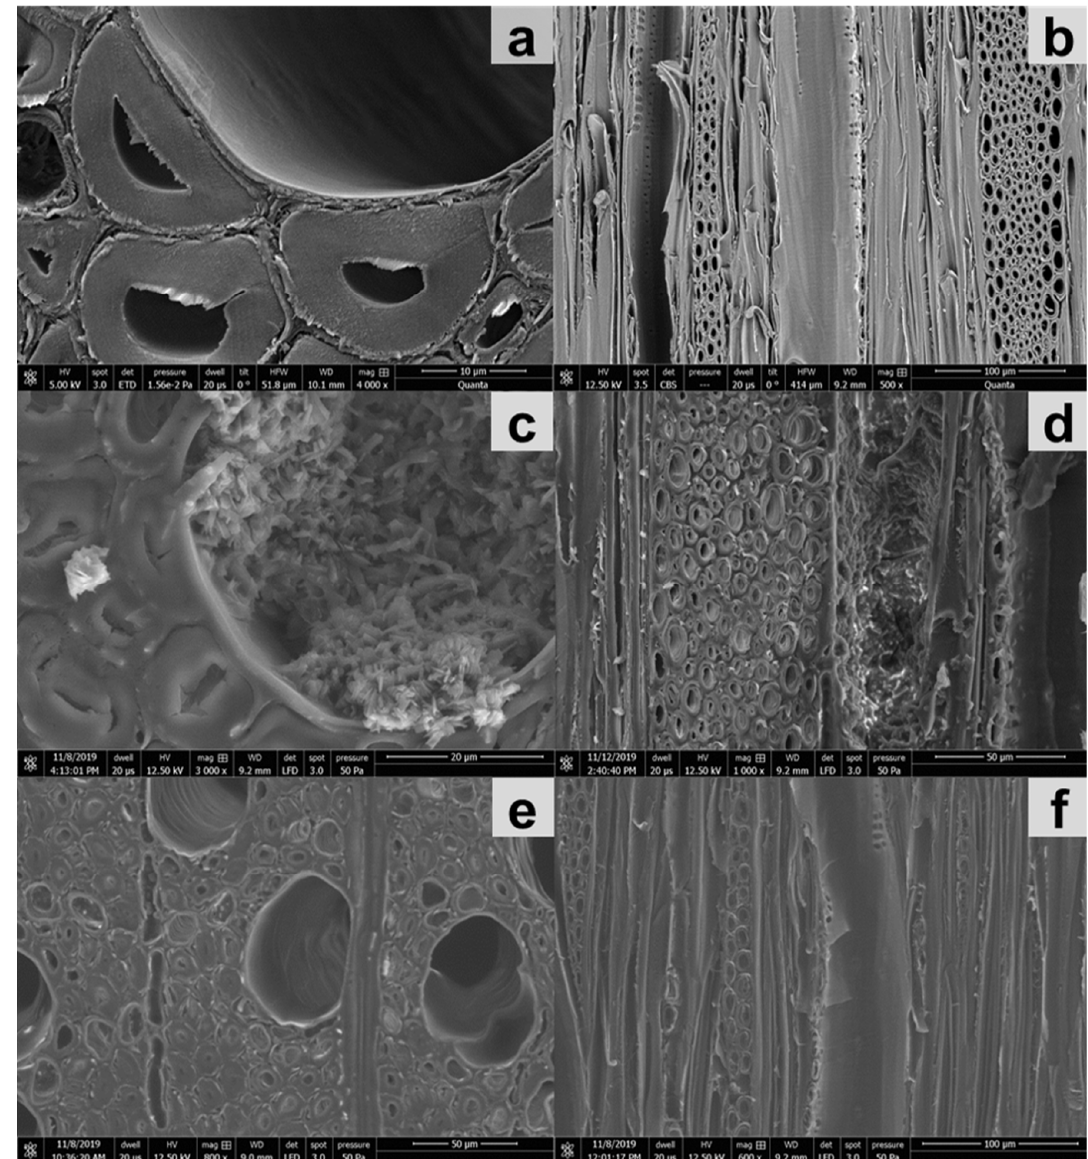
Figure 6. SEM micrographs of beech sapwood ( Fagus sylvatica ) treated with extractives. ( a , b ) Untreated wood block. ( c , d ) Beech wood treated with the heartwood extract of black locust (HWE). ( e , f ) Beech wood treated with knotwood extract of Scots pine (KWE). ( a , c , e ) Transverse sections. ( b , d , f ) Longitudinal sections. The images were obtained at magnifications of 500×, 1000×, 2500×, 4000× and 5000×.